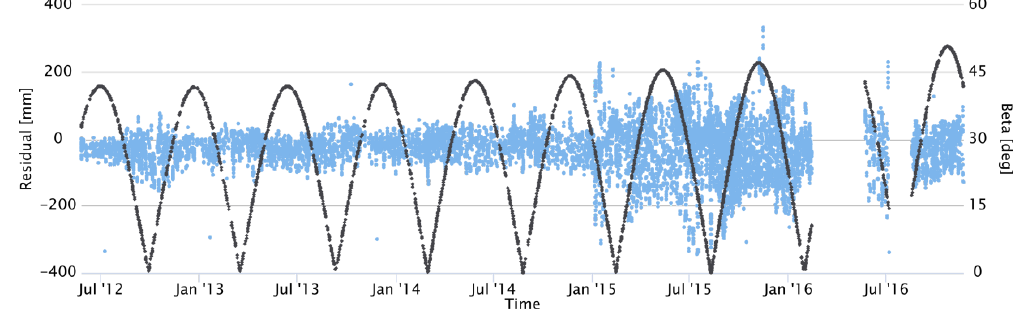
Figure 4. SLR residuals as a function of time; grey dots represents the change of |β| angles in time.